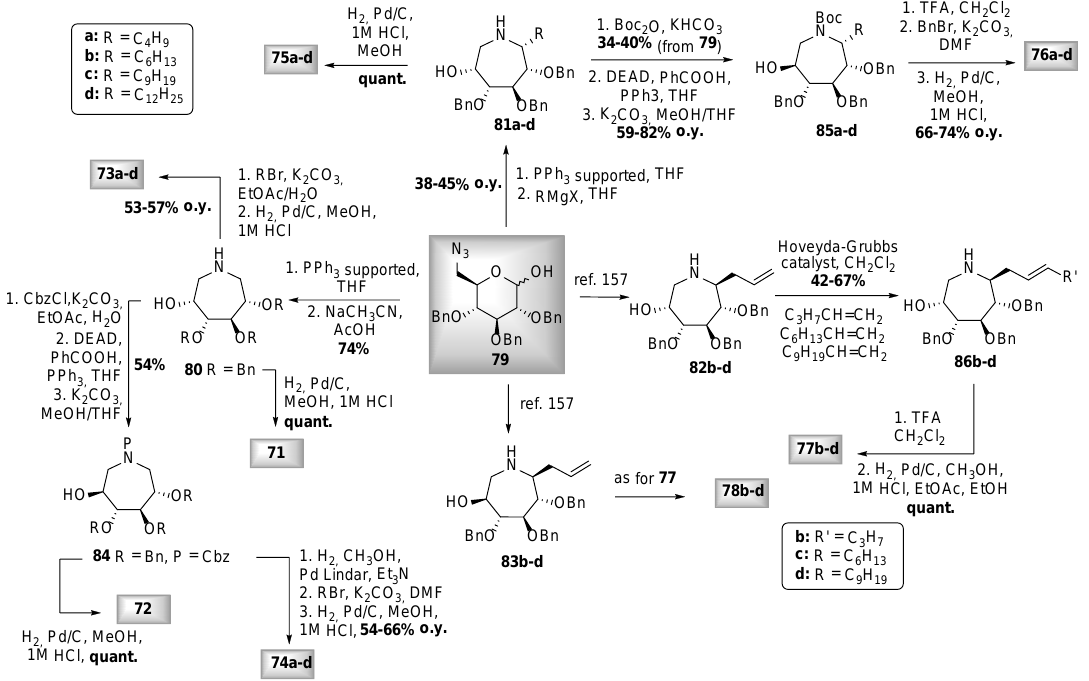
Scheme 10. Synthesis of N -alkyl and C -alkyl azepane iminosugars